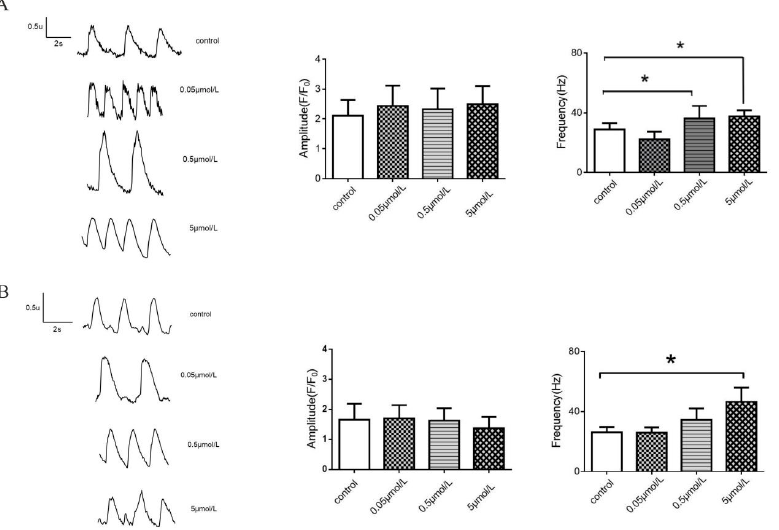
Figure 8. Effects of AC on calcium transients in normal and LQT syndrome hiPSC-CMs. ( A ) normal hiPSC-CMs; ( B ) LQT syndrome hiPSC-CMs. * Compared with the control group, p < 0.05. 2.6. Effects of AC on L-Type Calcium Current in Normal and LQTS hiPSC-CMs